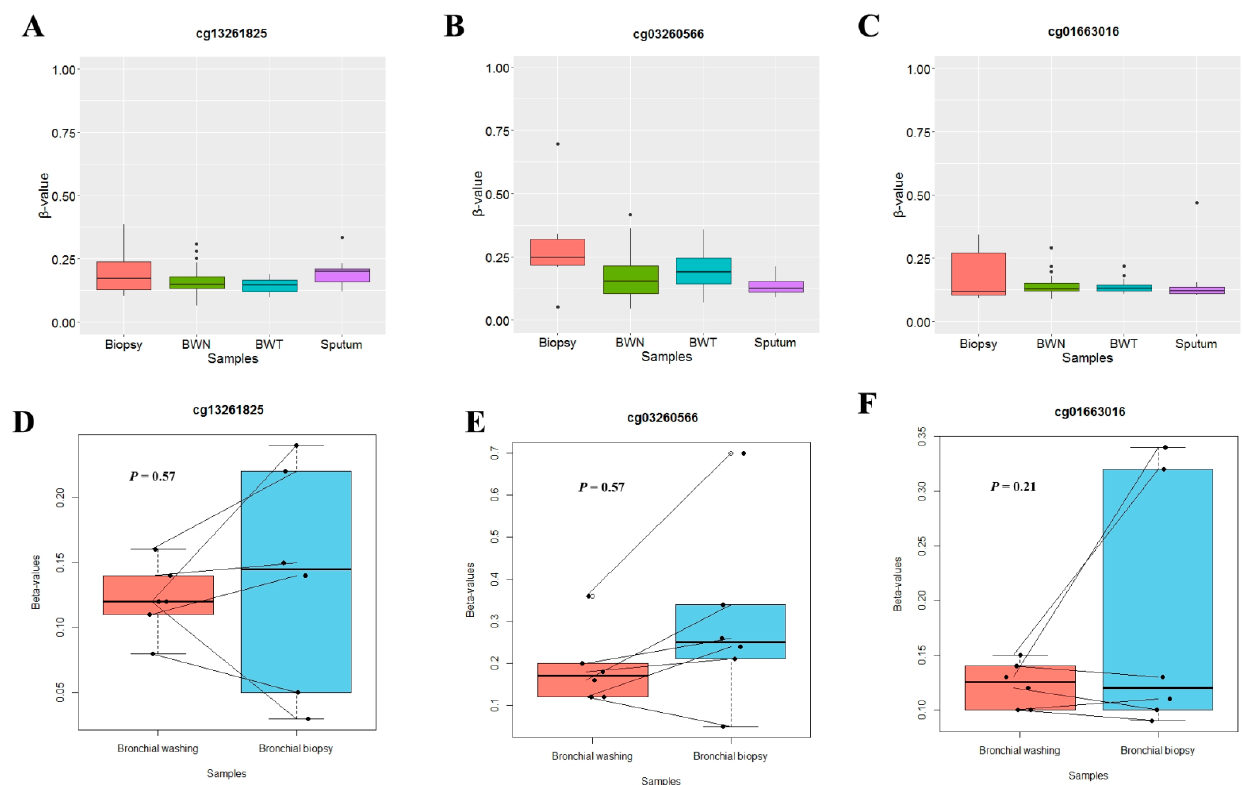
Figure 2. Aberrant methylation of SLIT genes in bronchial washing, biopsy, and sputum samples. ( A – C ) Methylation levels of three CpGs (( A ) cg13261825, ( B ) cg03260566 and ( C ) cg01663016) were compared in six bronchial biopsy and 12 sputum samples from NSCLC patients and in bronchial washing samples from 60 cancer-free patients (BWN) and 76 NSCLC patients (BWT). ( D – F ) Meth- ylation levels of these three CpGs were also analyzed between paired bronchial washing and bronchial biopsy specimens from six NSCLC patients. p -values are based on Wilcoxon signed rank test. Y-axis indicates β -value.